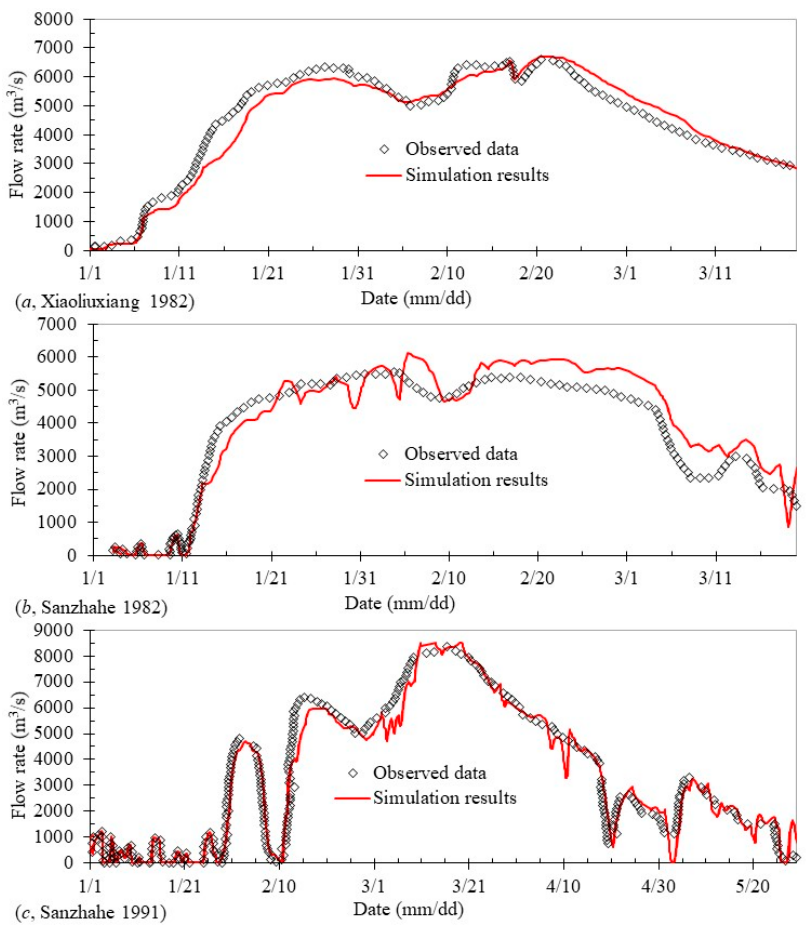
Figure 9. Simulated and observed flow rates with calibrated and validated model of two stations in 1982 and 1991: ( a ) for Xiaoliuxiang; ( b , c ) for Sanhe Gate station.